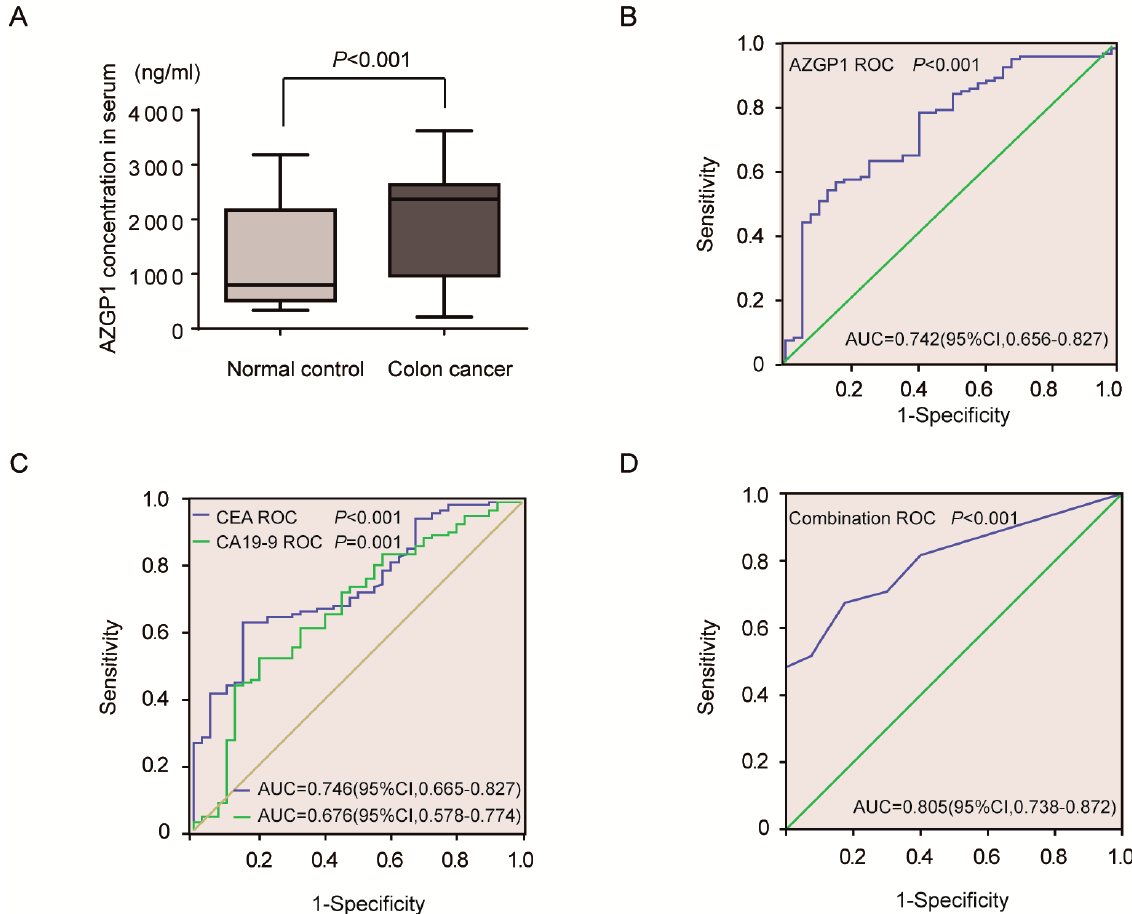
Figure 3. High serum concentrations of AZGP1 in colon cancer patients and high diagnostic value of serum AZGP1 for colon cancer. ( A ) Serum concentration of AZGP1 in colon cancer patients is higher compared with that in healthy controls ( p < 0.001); ( B ) The ROC of AZGP1. The AUC is 0.742 ( p < 0.001, 95% CI = 0.656–0.827). At the cutoff value of 2297.71 ng/mL for AZGP1, the sensitivity is 55.8% and the specificity is 85.0%; ( C ) The ROC of CEA and CA19-9. The AUC of CEA and CA19-9 are 0.746 ( p < 0.001, 95% CI = 0.665–0.827) and 0.676 ( p = 0.001, 95% CI = 0.578–0.774). At the cutoff value of 6.47 ng/mL for CEA and 44.77 U/mL for CA19-9, the sensitivity and specificity are 63.3% and 85%, 52.5% and 80.0%, respectively; ( D ) The ROC of combination of AZGP1, CEA and CA199. The AUC is 0.805 ( p < 0.001, 95% CI = 0.738–0.872). With a cutoff value of 2.13, the sensitivity and specificity are 67.5% and 82.5%,